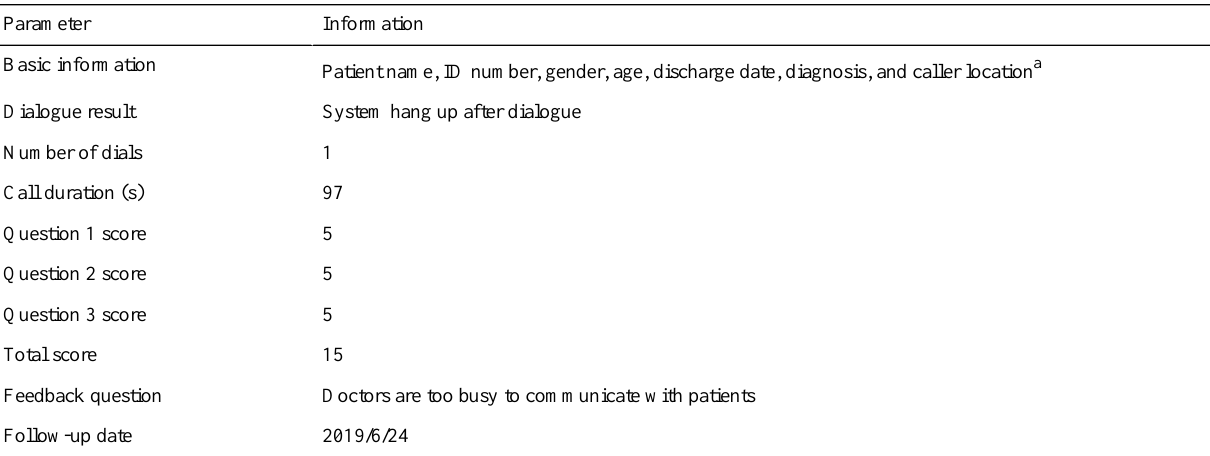
Table 1. Automatically generated table for the dialogue in Textbox 1.